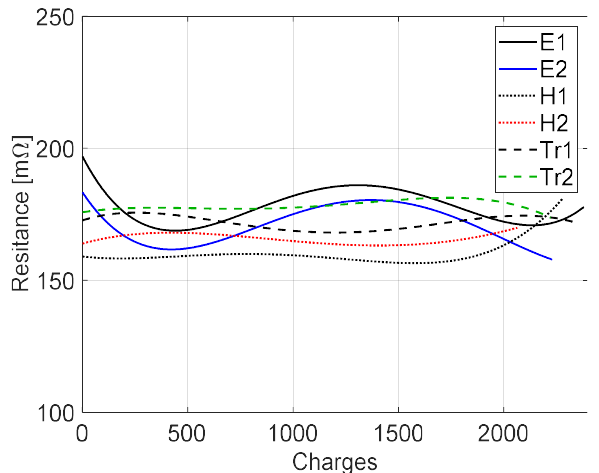
Figure 19. The average fast-charge resistance variation as a function of charges. The lines are the fourth-degree polynomial average internal resistances of the battery packs of the buses.